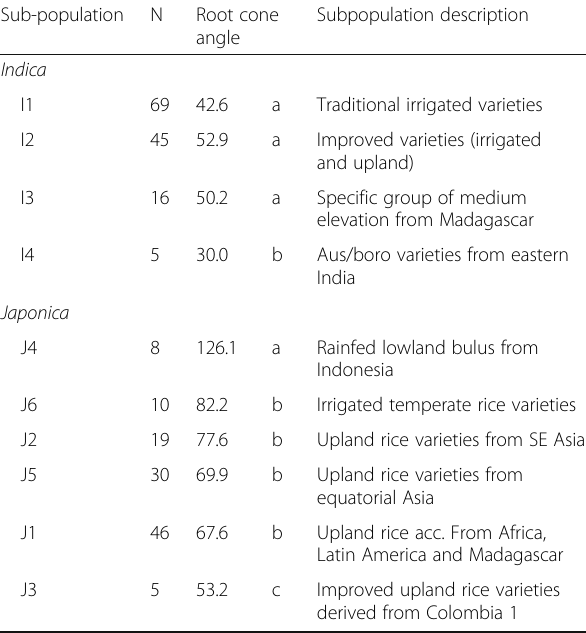
Table 2 Mean per subpopulation (admixed excluded)